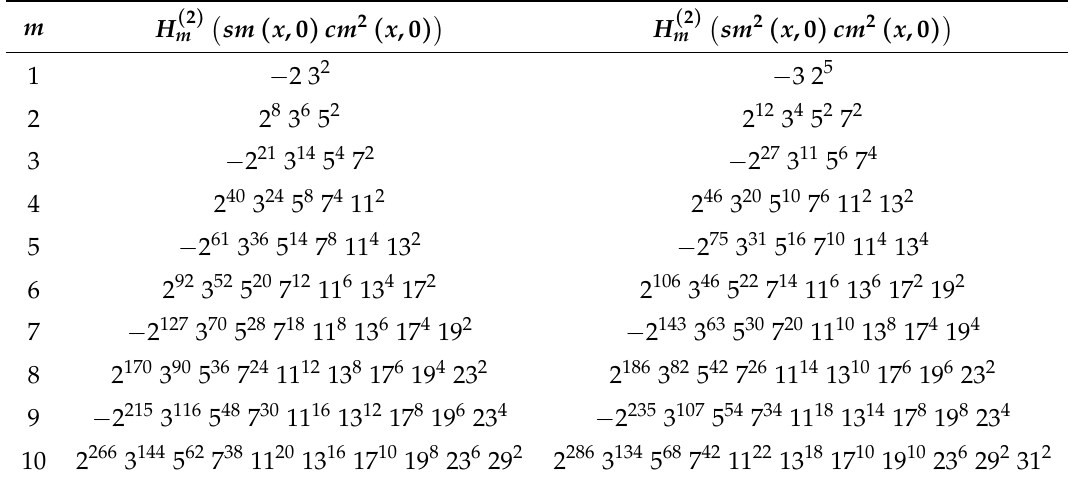
Hankel determinants H sm 2 ( x ,0 ) cm 2 ( x ,0 ) for m from 1–10.